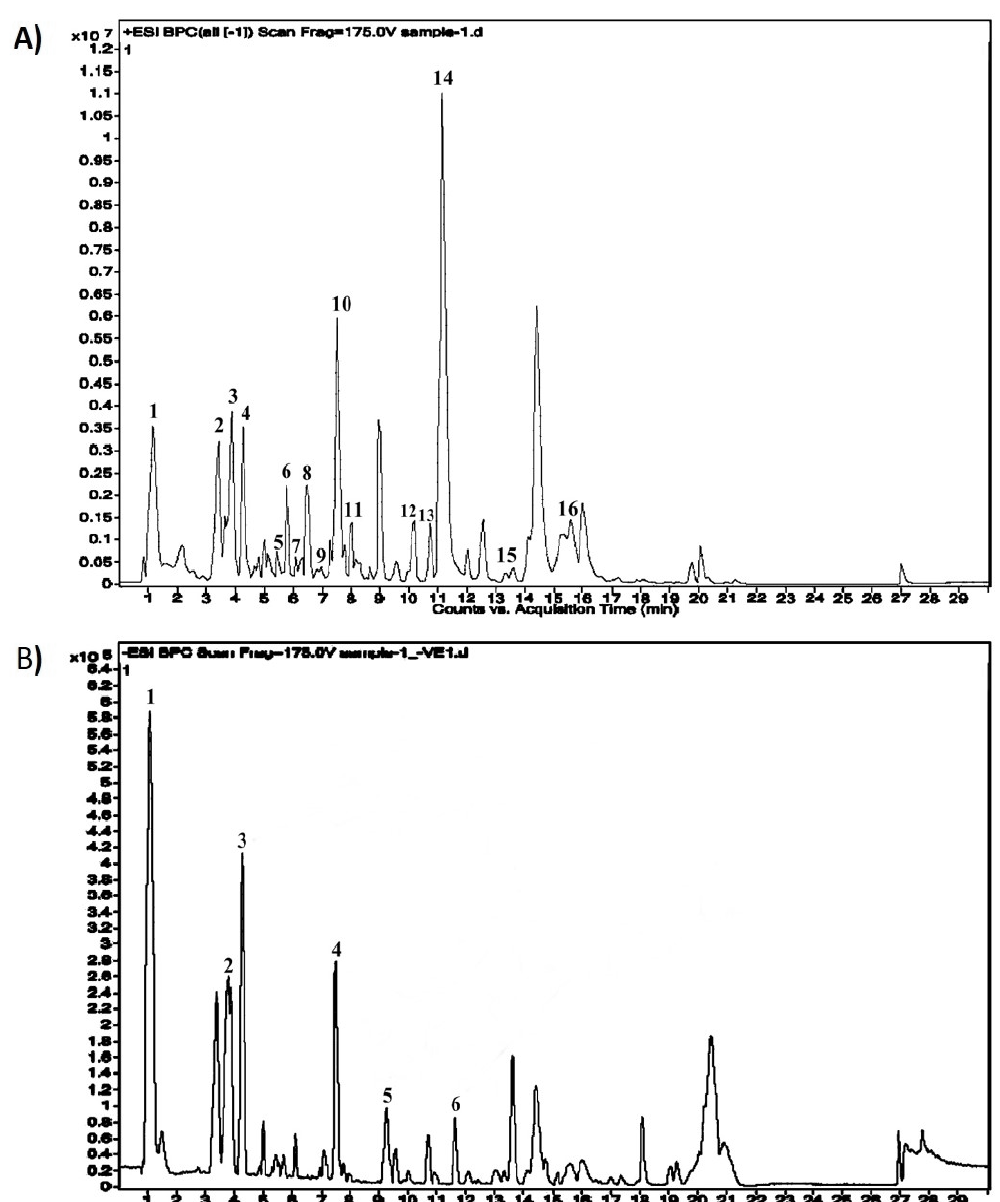
Figure 1. Phytochemical composition profile of Allium subhirsutum methanolic extract using the High Resolution-Liquid Chromatography Mass Spectroscopy (HR-LCMS) technique. ( A ) Positive peak (1). Pro Leu, (2). Cys Tyr Trp, (3). Glu Thr, (4). Asp Arg Tyr, (5). 2-methylene-5-